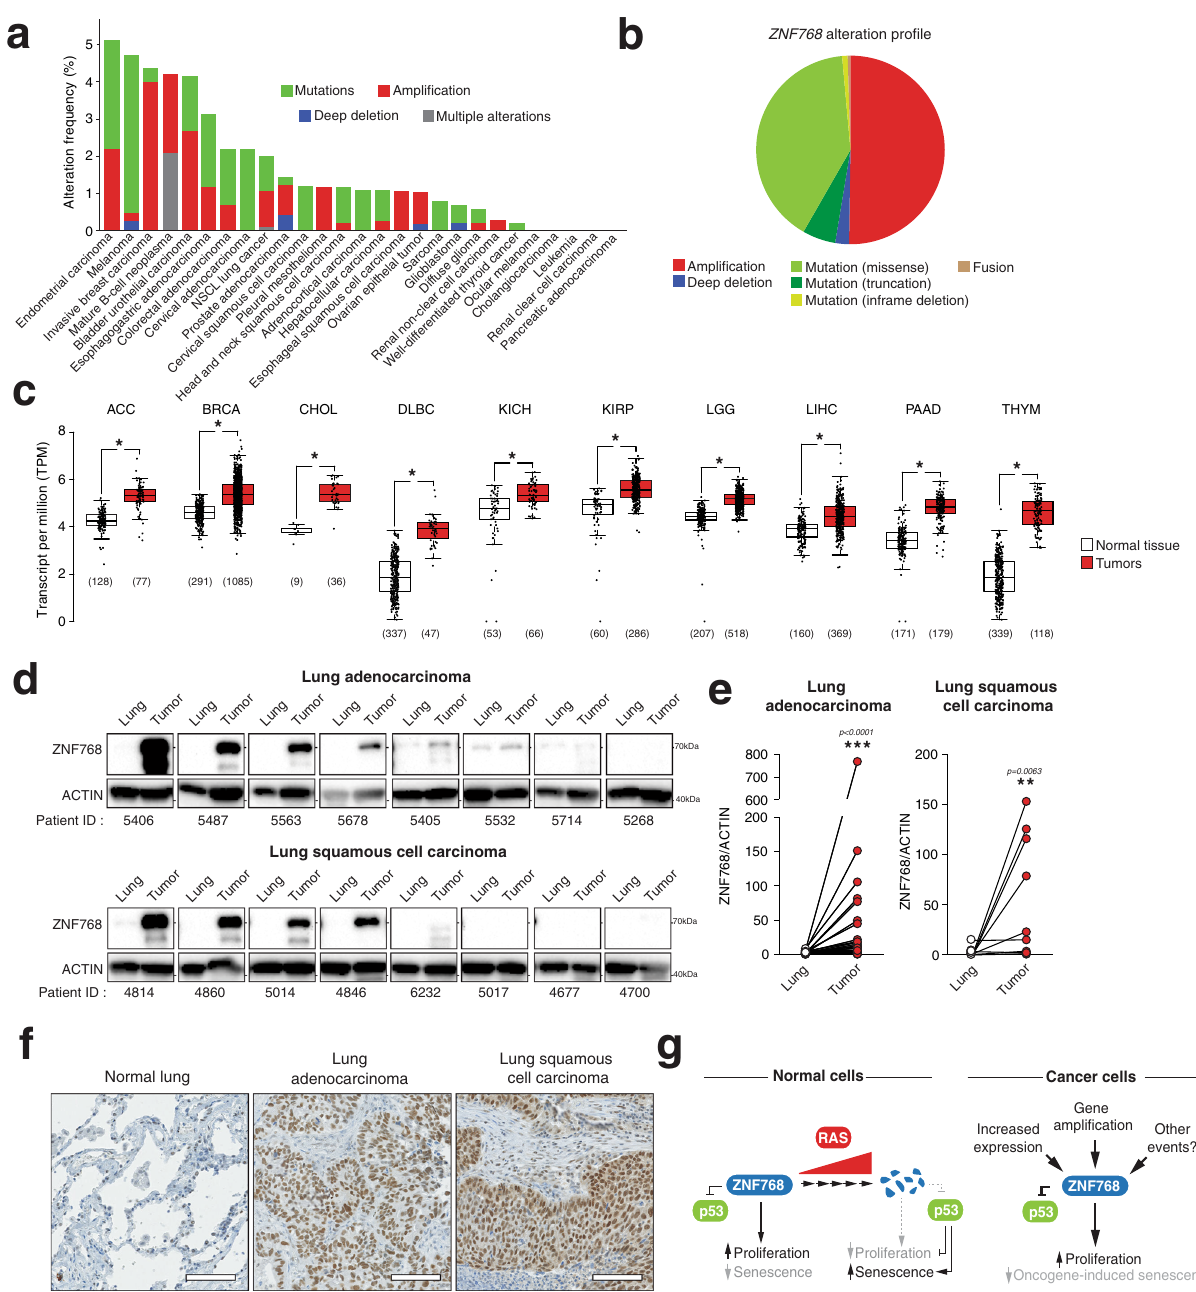
Fig. 6 ZNF768 expression and protein levels are elevated in several human cancers. A Large-scale cancer genomics analysis of ZNF768 mutation pro fi le performed using cBioportal and TCGA PanCancer Atlas Studies. B Distribution of ZNF768 alteration pro fi le based on the analysis described in ( A ). C Gene expression analysis of ZNF768 expression between normal and cancer tissues. This analysis was performed using the GEPIA resource. The method for differential analysis is one-way ANOVA, without adjustment for multiple comparisons. The Log2 fold change cut-off was set up at 0.5 and the p -value cut- off at 0.001 (* p < 0.001). Each dot represents one sample. The number ( n ) of sample analyzed is provided below each graph bar. The low and high limits of the box represent the lower and upper quartiles, respectively. The middle line in the box represents the median value. The whiskers are 1.5 times the interquartile range. D Western blot analyses of ZNF768 protein levels in lung tumors (adenocarcinoma ( n = 28) or squamous cell carcinoma ( n = 10) or normal lung samples collected from human patients. Representative samples are shown from the same exposure time. E Quanti fi cation of ZNF768 protein levels in the experiment described in ( D ). Signi fi cance was determined on log transformed data using two-tailed paired t test. F Immunohistochemistry analyses of ZNF768 protein in normal lung and lung tumors. Examples of tumors showing high levels of ZNF768 are presented (Scale: 100 µ m) . G Presentation of the proposed functions of ZNF768 in normal and cancer cells. In all panels, data represent the mean ± SEM. Details about reproducibility are provided in the Statistics and reproducibility included in the Methods section. Source data are provided as a Source data fi